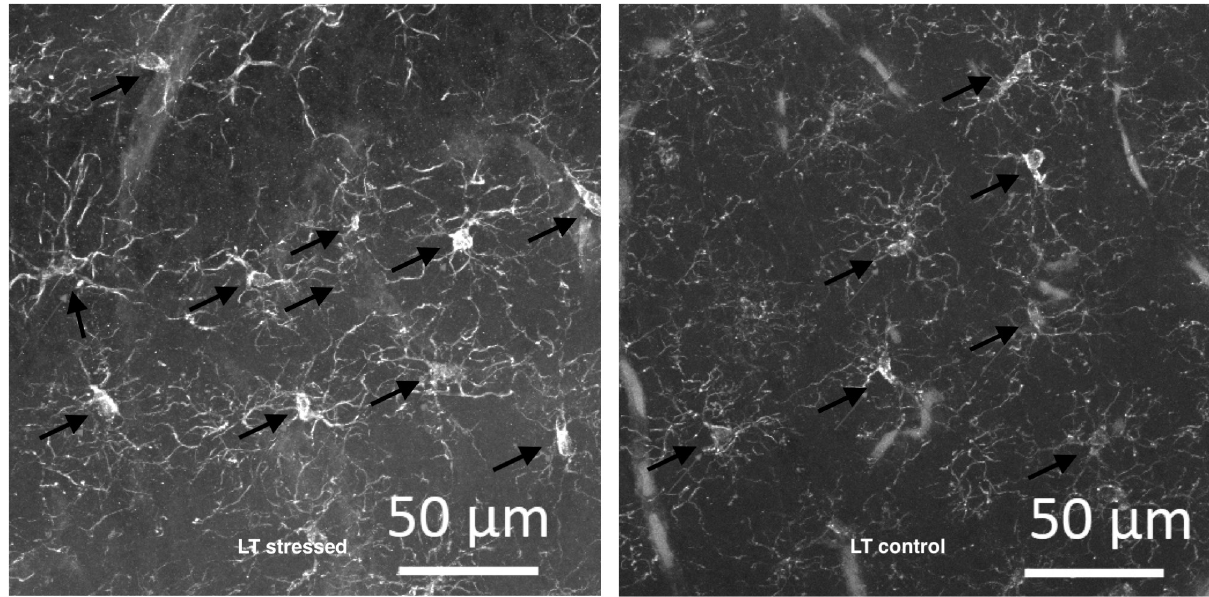
Fig 9. Iba1+ cells in the DG of LT stressed group (left) and LT control group (right).